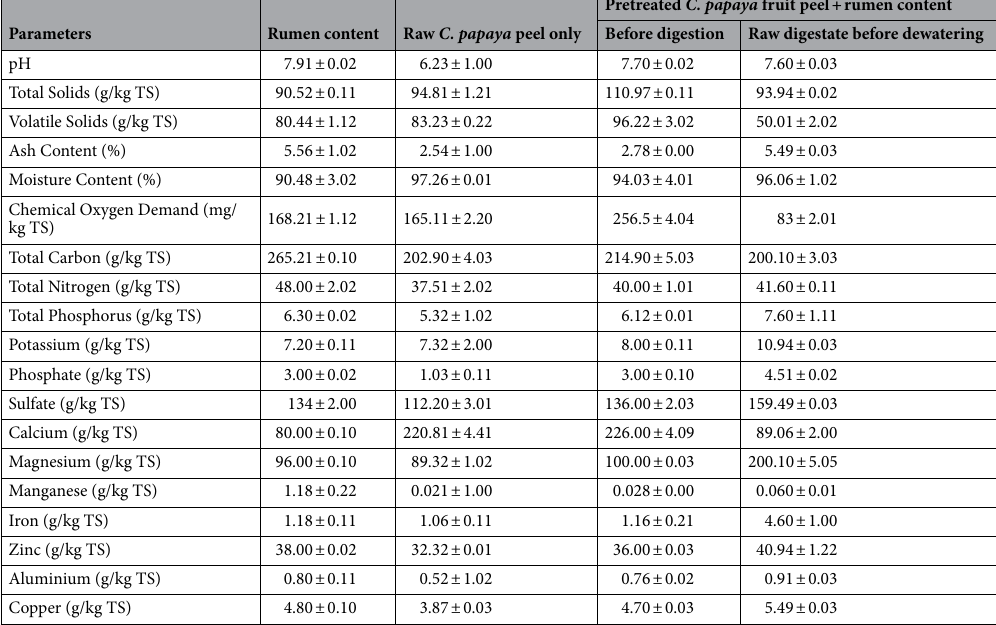
Table 3. Physical and chemical characteristics of Carica papaya fruit peel and cattle rumen content 38